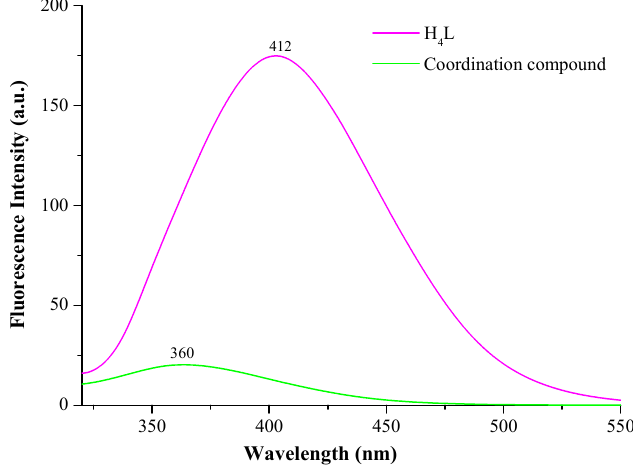
Figure 7. Fluorescence spectra of H 4 L and its Co(II) coordination compound in dilute CH 2 Cl 2 solutions (c = 1 ×10 −6 M, λ ex = 271 nm).